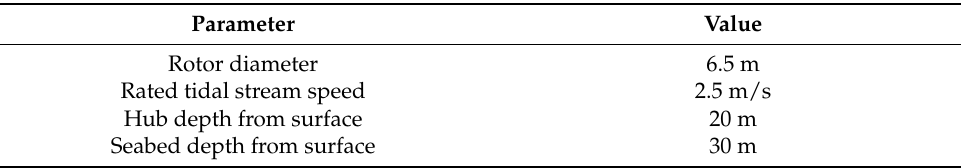
Figure 4. Fluctuations in the tidal stream velocity about its mean value (here taken as 3.3 m/s) as a consequence of turbulence and wave induced oscillations are shown here. In this figure, a TI value of 13% is used, and a surface wave of significant wave height Hs = 5.75 m and peak period = 11 s are used. This is an extreme case of wave induced oscillation to highlight the impact of waves. It must be noted such waves rarely occur [2]. Table 1. Turbine rotor